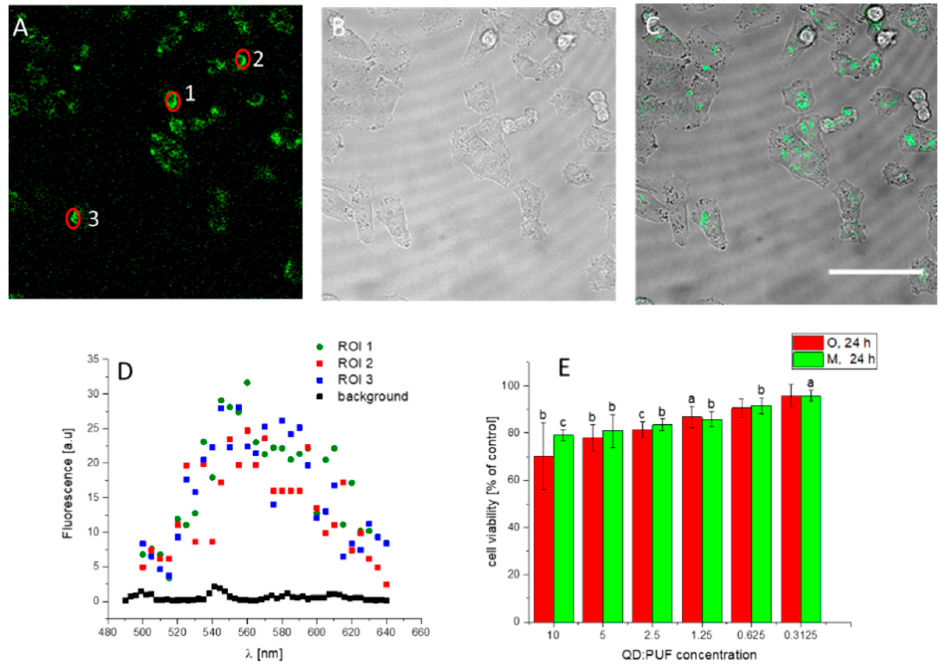
Figure 4. Puf:QD nanohybrids visualized inside A375 cells after 24 h of incubation. The growth medium contained 10 nM of QD:Puf. CLSM images ( A ) fluorescence emission (excitation 450 nm, emission 550–650 nm), ( B ) bright-field and ( C ) image overlay. The bar is 65 µm. ( D ) emission spectra recorded for ROIs marked as the red circle in the image ( A ), background and control emission de- tected in untreated, control cells. ( E ) Changes in HeLa cell viability in response to decreasing con- centration of Puf:QD in a growth medium. Two different fractions (O, oligomers, and M, monomers) were tested in a series of dilutions. Data show the ratio of average treatment to control, while error bars represent the standard deviation of % of control (calculated as the derivative of individual SD of treated and control samples). Letters a, b and c indicate a statistically significant difference be- tween given conditions and control (no QD:Puf) at p < 0.05, p < 0.01 and p < 0.001, respectively. 4. Conclusions QD:Puf preparation was shown to be stable during the experiments and the particles were successfully delivered inside HeLa and A375 melanoma cells by simple uptake from the growth medium. The accumulation of measurable fluorescence intensity required at least 6–10 h exposure, suggesting that the net observed signal was the result of endo- and exocytosis. Both monomeric QD:Puf and the relatively large oligomers of QD:Puf may be accumulated inside cells; however, the presence of oligomers resulted in higher cytotoxi- city. QD fluorescence localized in the ER, with regions of higher intensity (probably the Golgi apparatus). Therefore, it is possible that the observed toxicity was not (or not only) due to Cd 2+ ion release, but due to disturbance of ER function. The fluorescence emission maximum was red-shifted inside the cells and the fluores- cence lifetime was shortened, indicating some influence of the cell microenvironment on the QD surface. These observations might be an indirect effect, related to changes in the covering protein, Puf, and to amino acid ionization. In sum, we have demonstrated that QD cover, composed of long peptides, assures good nanoparticle performance in cell studies. This makes Puf and its derivatives the next option in fluorescent probes and sensor development. In such applications, a Puf-based (or other peptide-based) cover offers places for secondary chemistry to occur on the na- noparticle surface. A protein-based cover may provide protection of the nanoparticle sur- face from the reactive cellular interior, resulting in resistance to decomposition and